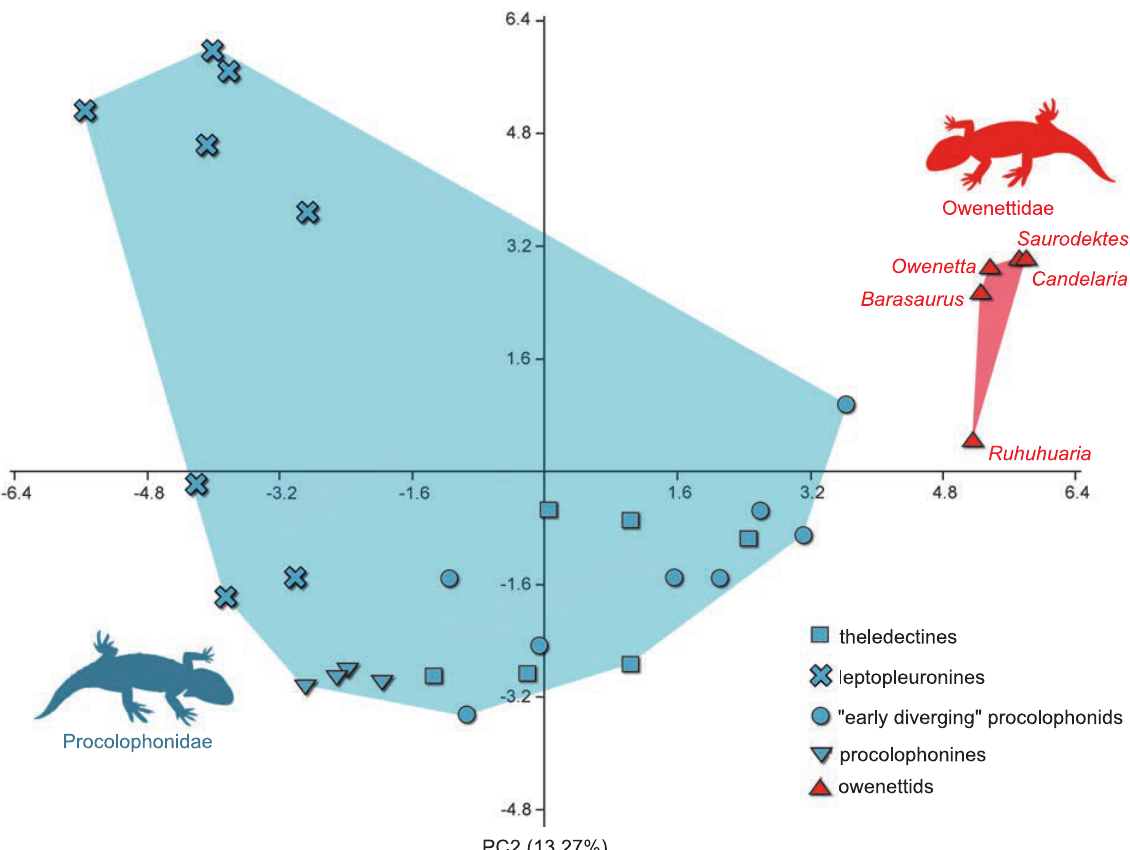
Fig. 6. Bivariate plot showing the results of the morphospace occupation analysis. Red convex hull corresponds to morphospace of owenettids and blue convex hull corresponds to morphospace of